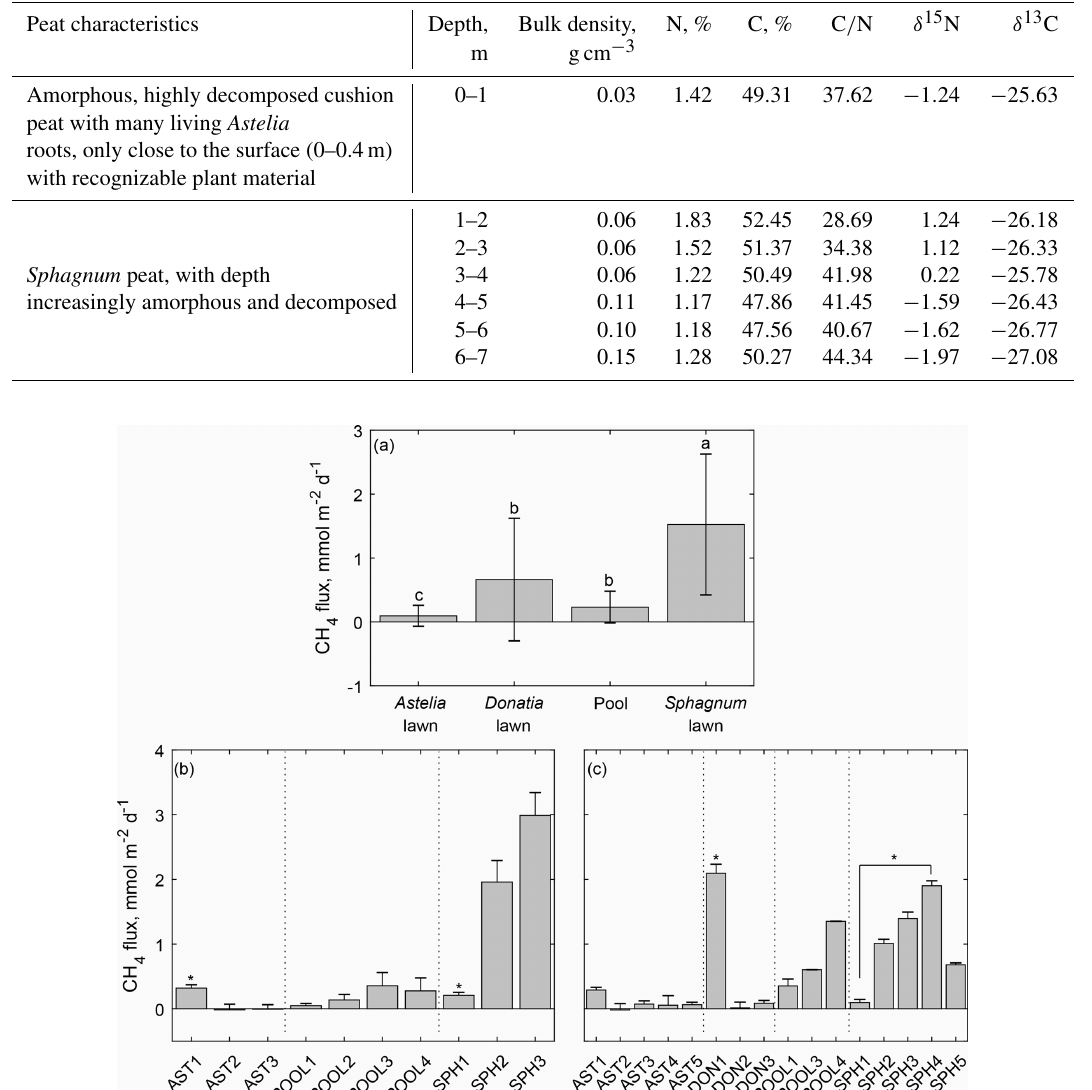
Figure 3. Mean CH 4 emissions and their standard deviation determined from dominant microforms ( a ) and individual collars during the two measurement campaigns ( b, c ) in a Patagonian cushion bog. Different letter superscripts denote significantly different amounts of emitted CH 4 among microforms despite variability within microforms being substantial ( a ) or from collars within one microform ( b, c ) that were identified by Kruskal–Wallis analysis of variance and multiple comparison U tests with Bonferroni